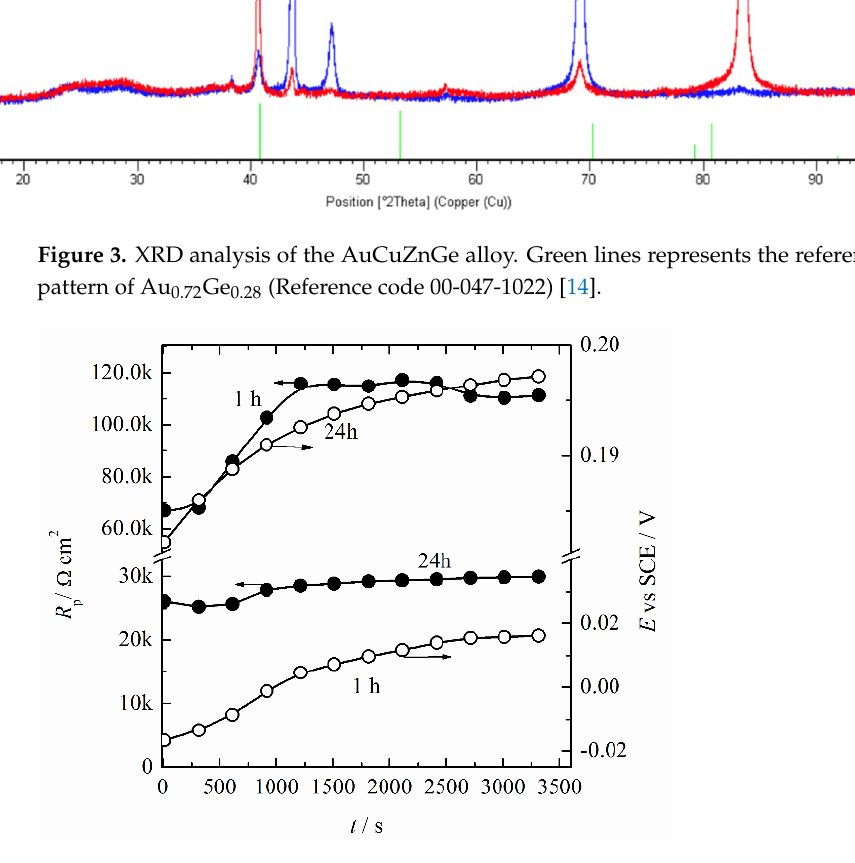
Figure 3. XRD analysis of the AuCuZnGe alloy. Green lines represents the reference line for XRD pattern of Au 0,72 Ge 0,28 (Reference code 00-047-1022) [14].